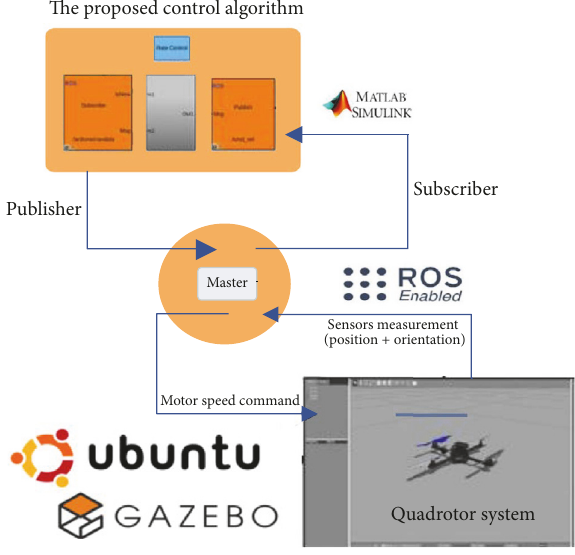
Figure 12: Simulation environment configuration.